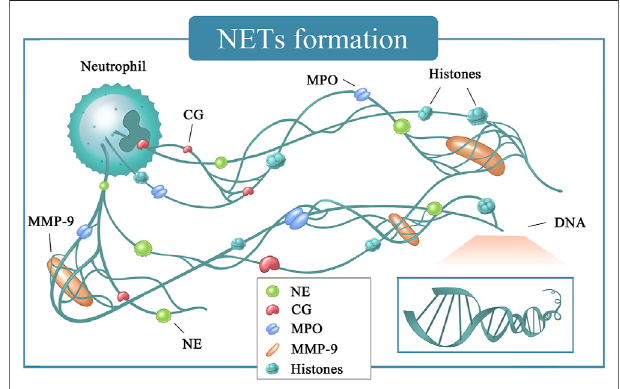
FIGURE 5 | NETs formation. CG, cathepsin G; DNA, deoxyriboNucleic acid; MMP-9, matrix metalloproteinase-9; MPO, myeloperoxidase; NE, neutrophil